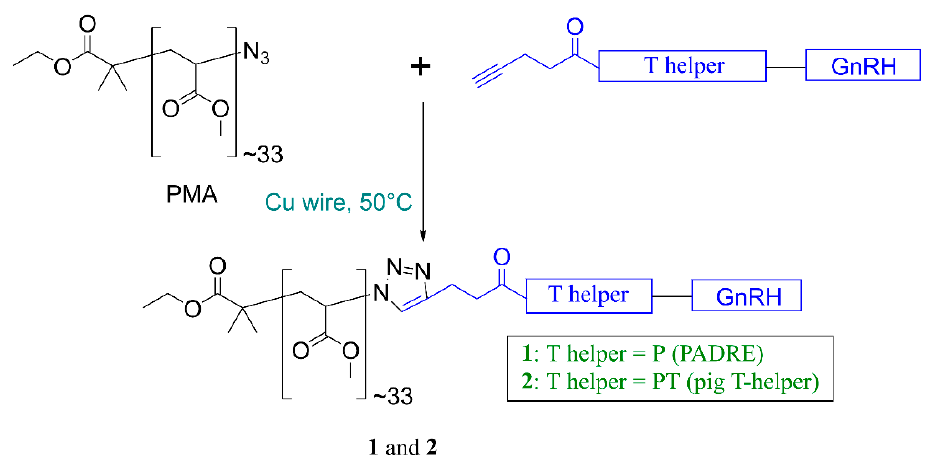
Figure 2. Synthesis of vaccine candidates 1 and 2 . PMA, poly(methylacrylate) azide.